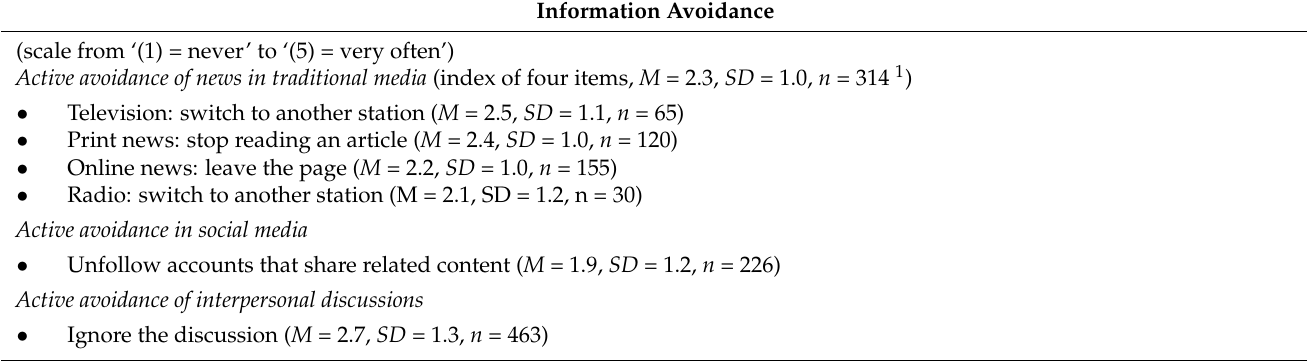
Table 2. Indices and single items for information avoidance, extended coping, and secondary emotions and